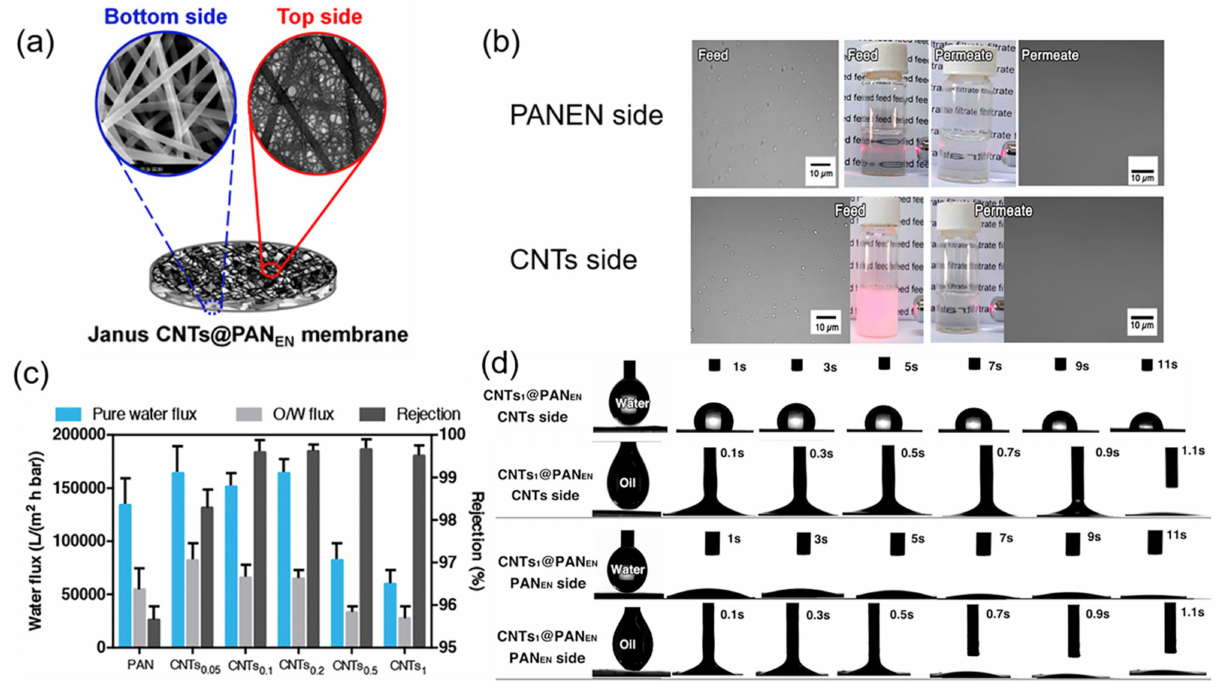
Figure 9. ( a ) Schematic illustration and SEM images of Janus PAN/CNTs ENMs; ( b ) separation results by two sides of Janus PAN/CNTs 0 . 5 ENMs; ( c ) pure water flux, O/W flux and water rejection by the pure PAN and PAN/CNTs ENMs; ( d ) spreading behaviors of water and oil droplet on two sides of PAN/CNTs 0 . 5 ENMs. Reprinted with permission from Ref. [133]. 2017,